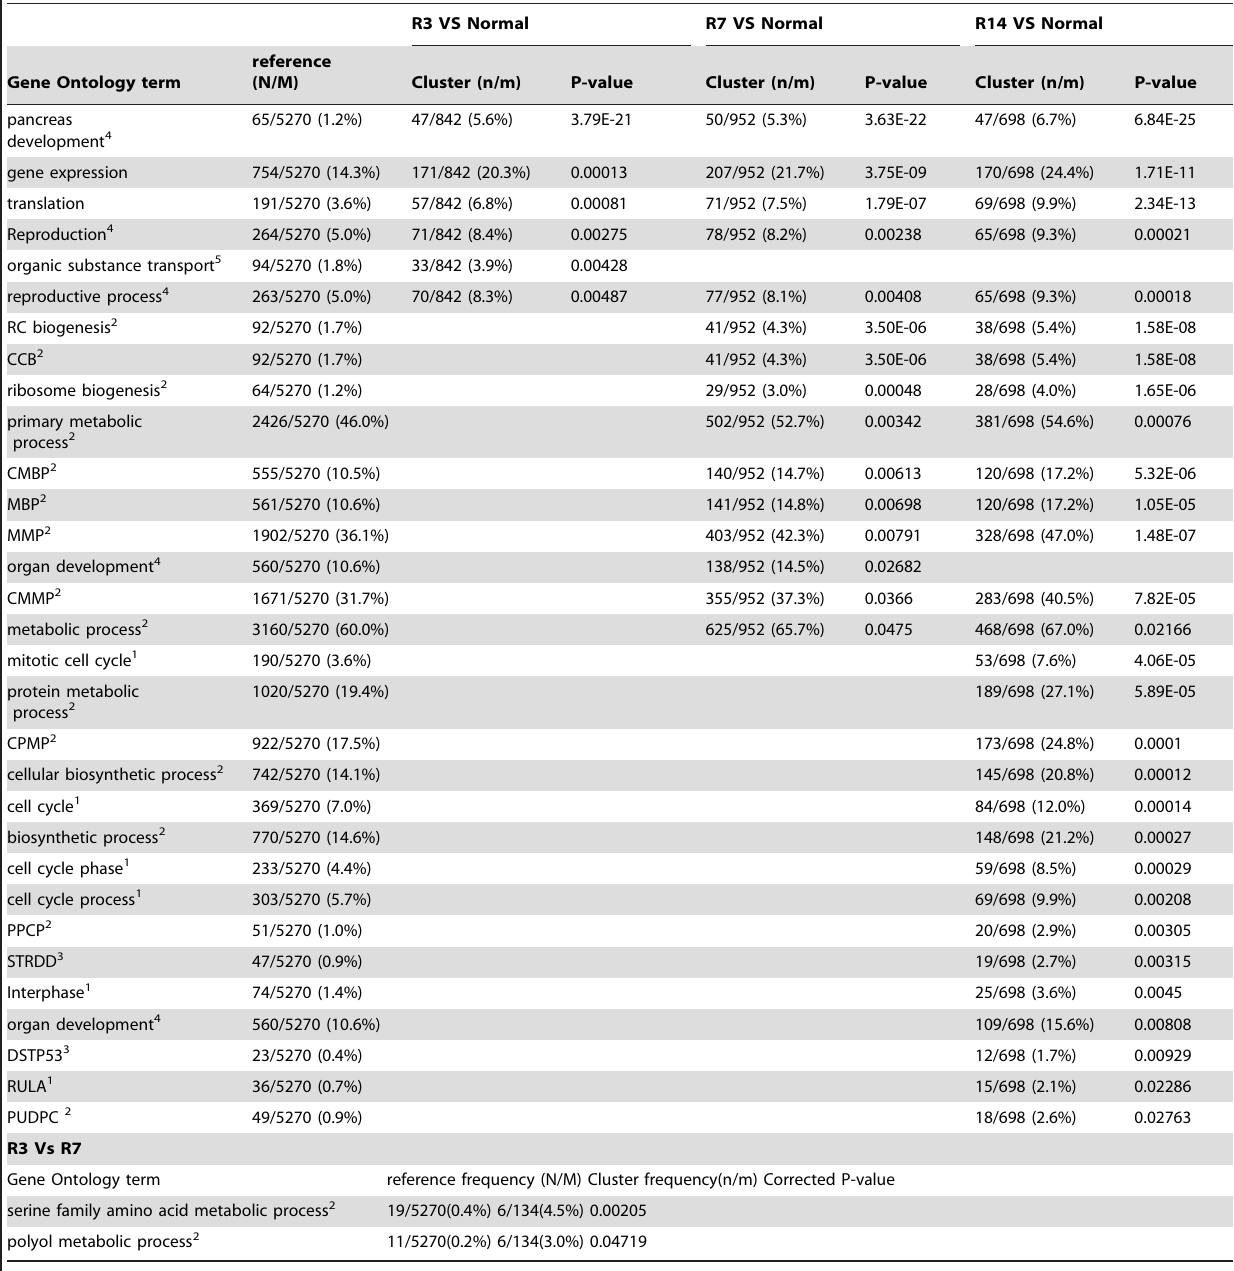
Table 8. Significantly enriched GO terms in